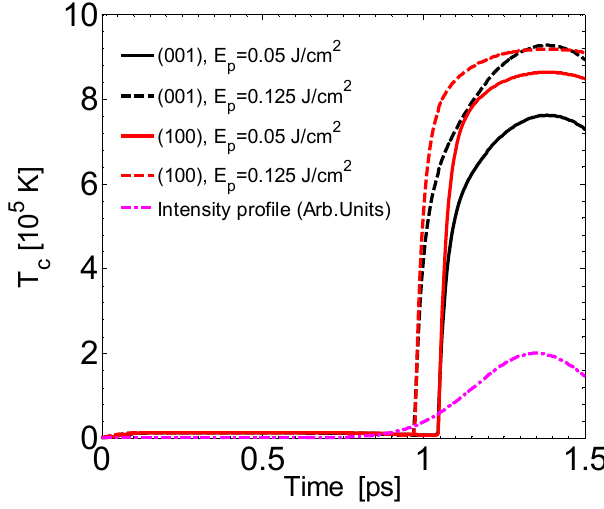
Figure A1. Evolution of values of carrier for E p = 50 mJ/cm 2 and 125 mJ/cm 2 for (001) and (100) crystal orientation at x = y = 0 and on the surface of the material.